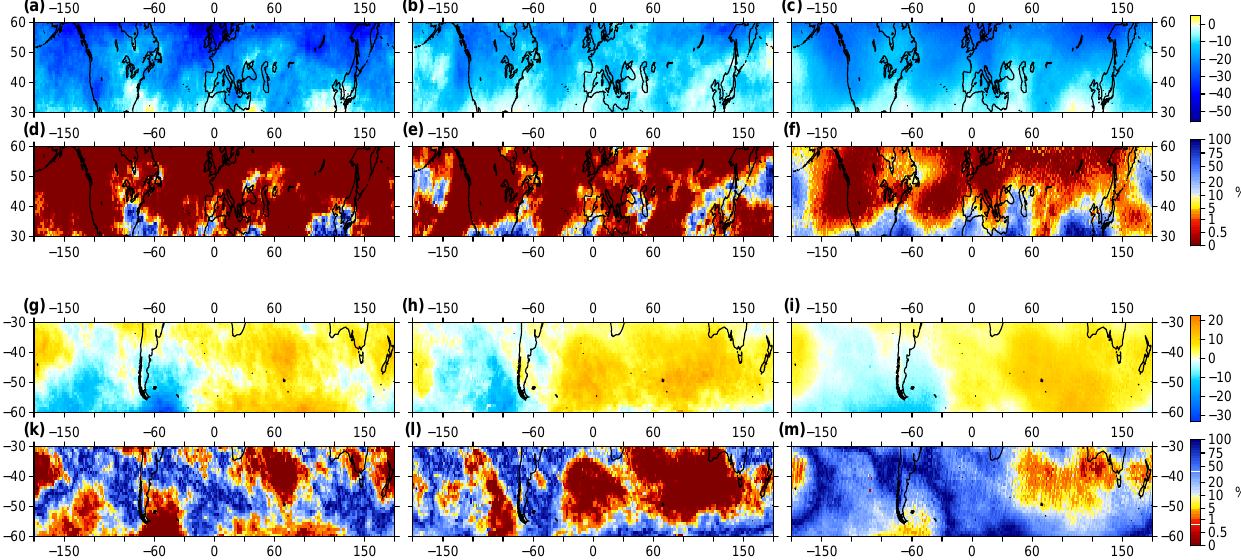
Fig. 6. Pointwise regression coefficient estimates (in DU ( unitSatoIndex ) − 1 ) for the volcanic eruption of Mt. Pinatubo on an annual basis for (a) EHOs, (b) ELOs, and (c) mean values of total ozone at 30 ◦ N to 60 ◦ N; (d) – (f) show the p -values of the pointwise significance tests for the estimates in (a) – (c) . (g) – (m) as (a) – (f) but at 30 ◦ S to 60 ◦ S. An augmented version of this figure including standard errors for all coefficient estimates is provided in Fig.